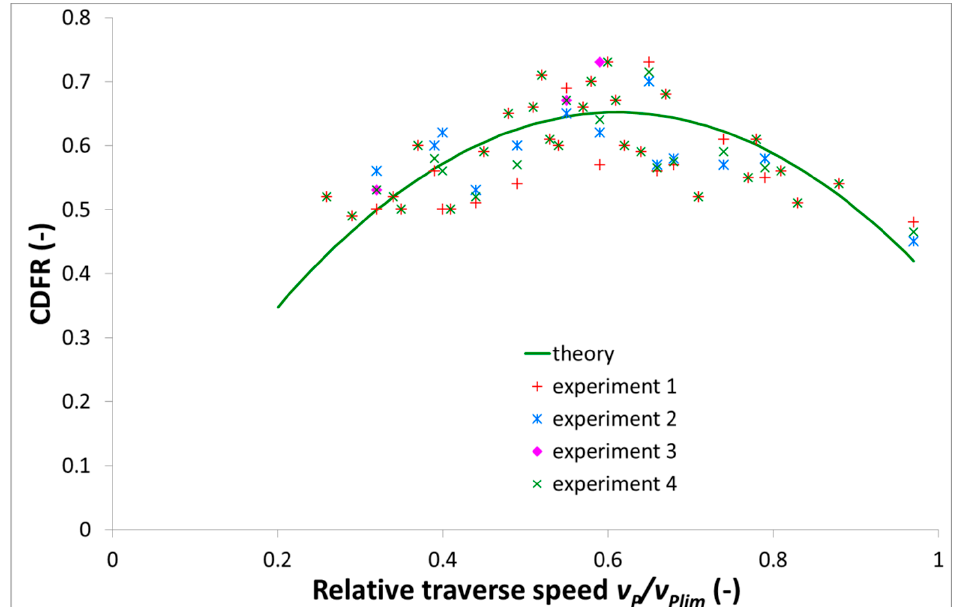
Figure 4. Relationship between the cutting to deformation force ratio (CDFR) values and the relative traverse speed values.